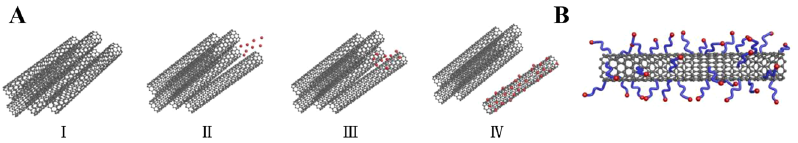
Figure 1: Dispersion of CNTs with surfactants. (A) Mechanism of SWNT isolation from bundles by ultrasonication and surfactants. Kim et al. [114]. © The Royal Society of Chemistry 2020. (B) Random adsorption of surfactant molecules on a single SWNT. CNT, carbon nanotube; SWNT, single-walled CNT. Yurekli et al. [116]. © American Chemical Society